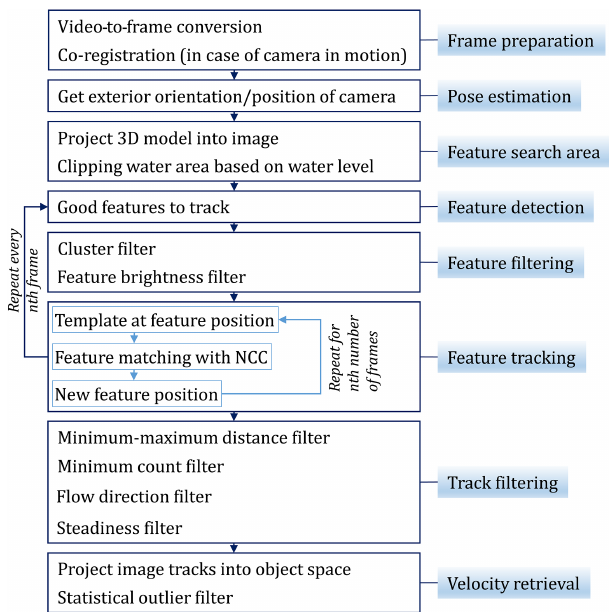
Figure 2. Workflow to retrieve flow velocities from video se-